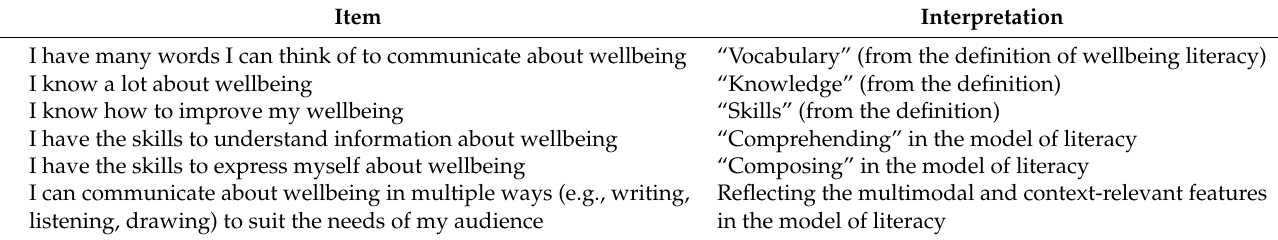
Table 1. Items of Well-Lit